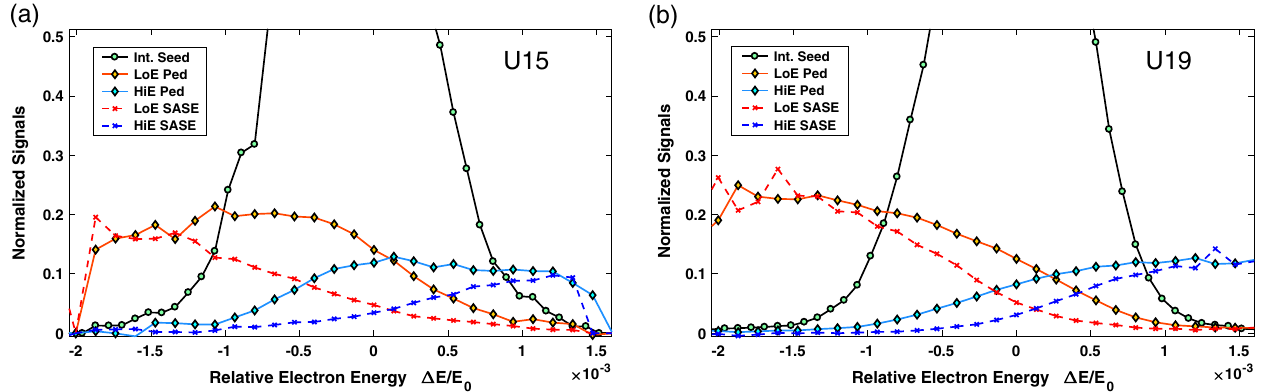
FIG. 12. Amplified seed strength ( “ Int. Seed ” ), upper ( “ HiE Ped ” ) and lower ( “ LoE Ped ” ) pedestal wavelength region strength, and separate upper/lower SASE (i.e., blocked seed) strength as a function of electron beam detuning Δ E B for two different effective undulator lengths in the November 2017 shift; the LH strength was 12 μ J in both cases. All curves are normalized to the peak value of the integrated seed with respect to Δ E B